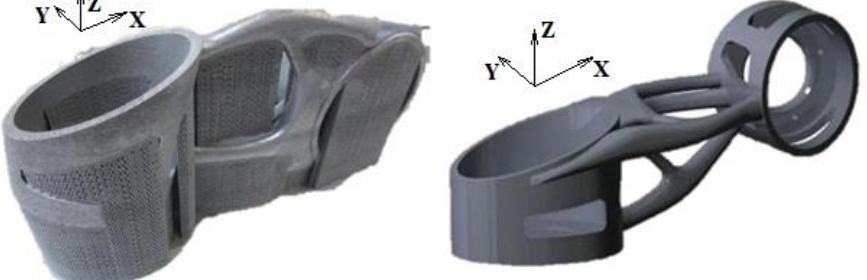
Figure 2. Arm I — additive manufacturing (AdM) made on 3D printer Xline 2000R. Figure 2. Arm I—additive manufacturing (AdM) made on 3D printer Xline 2000R. Y, Z, X in Figure 2 represent the Cartesian coordinate system, i.e., the orientation